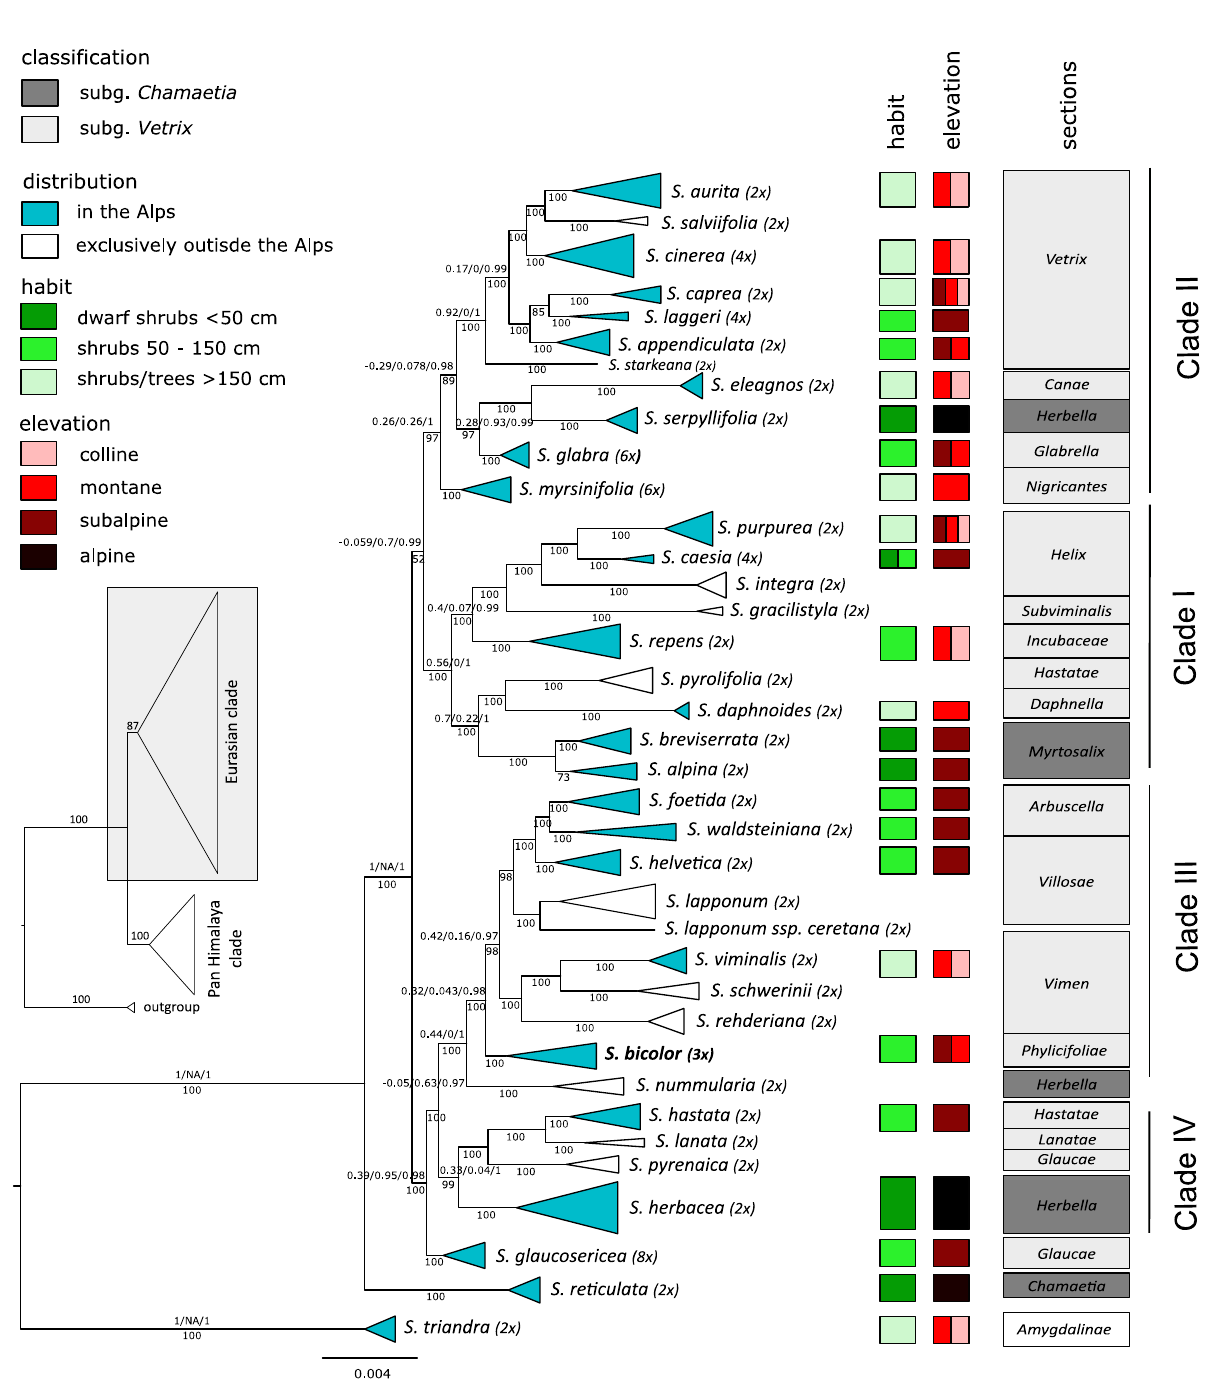
Figure 2. Summarized RAxML phylogeny of 133 accessions representing 35 species of the Salix Chamaetia/Vetrix clade based on 23,393 RAD loci. Bootstrap support (BS) values below and quartet sampling (QS) values above branches. Species occurring in the Alps are indicated by blue color. Habit and elevational distribution are indicated in colored boxes behind species names following color legend. Sectional classification is shown in gray boxes, traditional subgeneric classification is indicated by dark gray (subg. Chamaetia ) and light gray (subg. Vetrix ) (edited after [7], elevation after [1]).